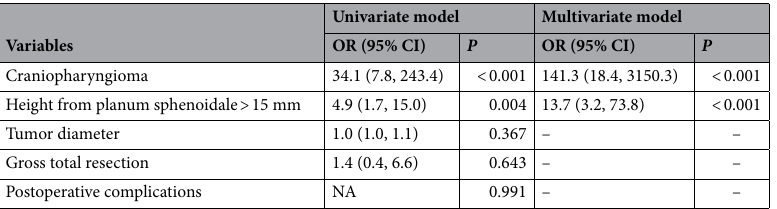
Table 3. Preoperative prediction models for postoperative permanent diabetes insipidus. OR, Odds ratio; CI, Confidence Interval; NA, Not applicable.